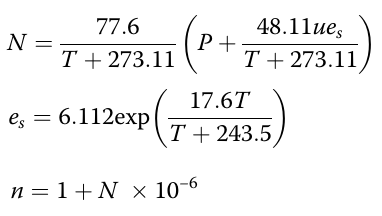
( red ) plotted as a function of time during flight UAV 17. Thin lines show the mean T ; UAV and ε UAV values are comparable in magnitude. T ; UAV